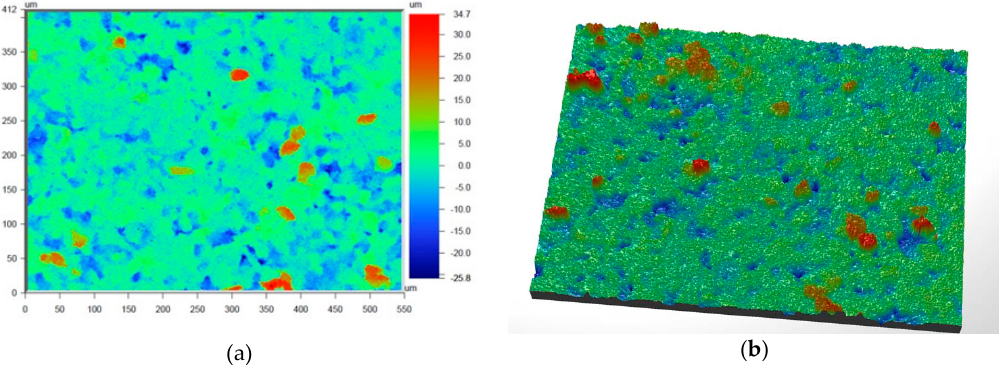
Figure 12. 2D ( a ) and 3D ( b ) profilographs of PW2 sample at a magnification of ×11.5.